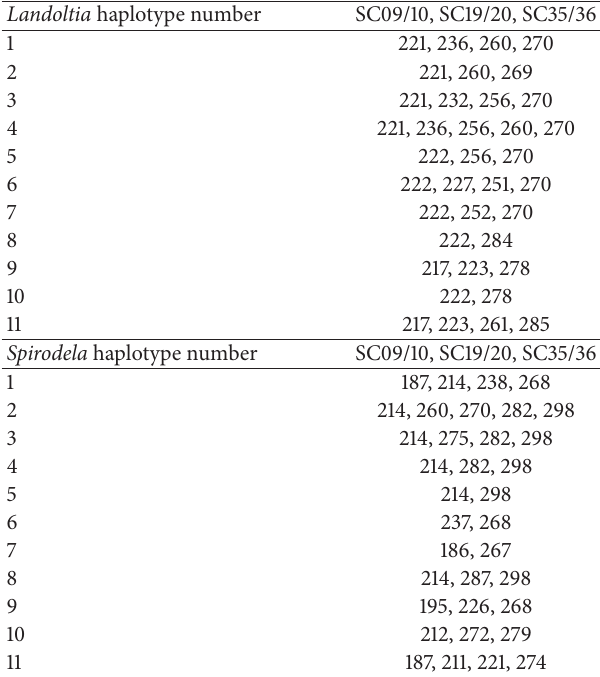
Table 4: Multilocus haplotypes defined with three pairs of primers. Alleles codes correspond to the size of the PCR